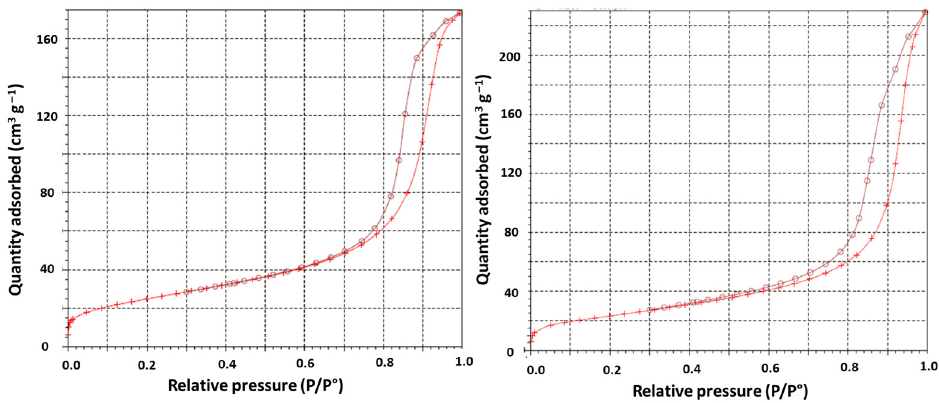
Figure 4. Adsorption and desorption isotherms of SCD ( left ) and F-SCD ( right ).